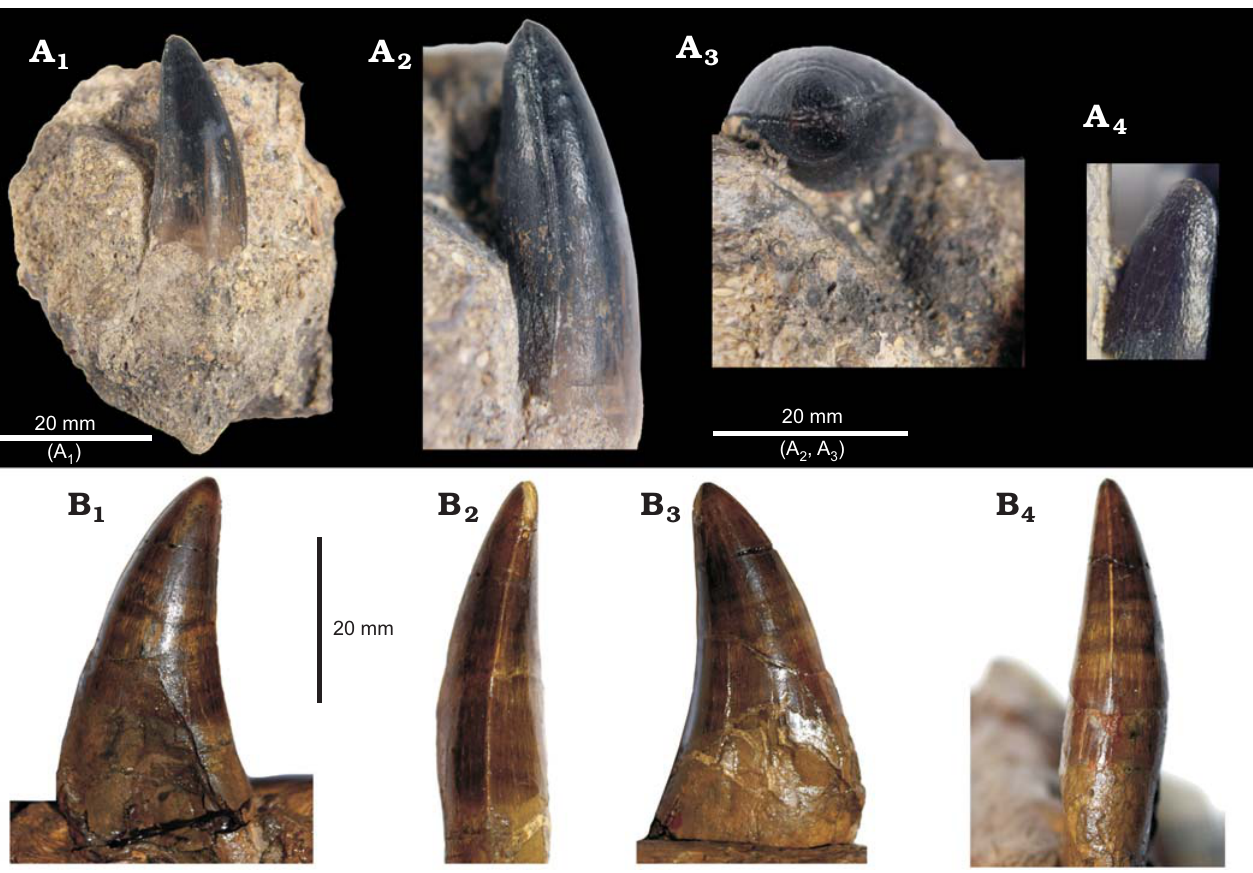
Fig. 11. Teeth of the metriorhynchid reptile Tyrannoneustes. A . YORYM:2016.308, cf. Tyrannoneustes , from Malton (Yorkshire), middle Oxfordian, in labial (A 1 ), axial (A 2 ), and apical (A 3 ) views, detail of the apex of the crown (A 4 , not to scale). B . NHMUK PV R3939, Tyrannoneustes lythrodectikos Young, Andrade, Brusatte, Sakamoto, and Liston, 2013a, from Peterborough (Cambridgeshire), Callovian, dentary tooth crushed at its base resulting more laterally compressed than in life, in labial (B 1 ), axial (B 2 , B 4 ), and lingual (B 3 )